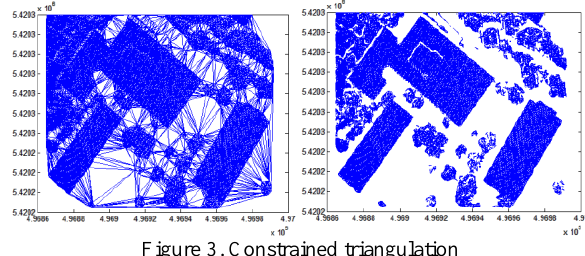
Where s = mean of the length of the triangle's sides. t = variance factor.  = standard deviation of the length of the triangle's sides.